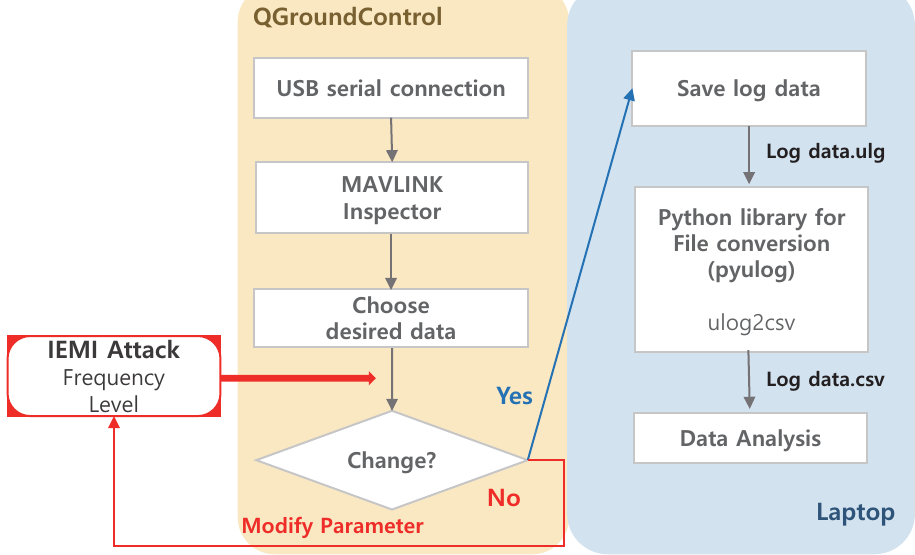
Figure 3. Block diagram for sensor data monitoring using log